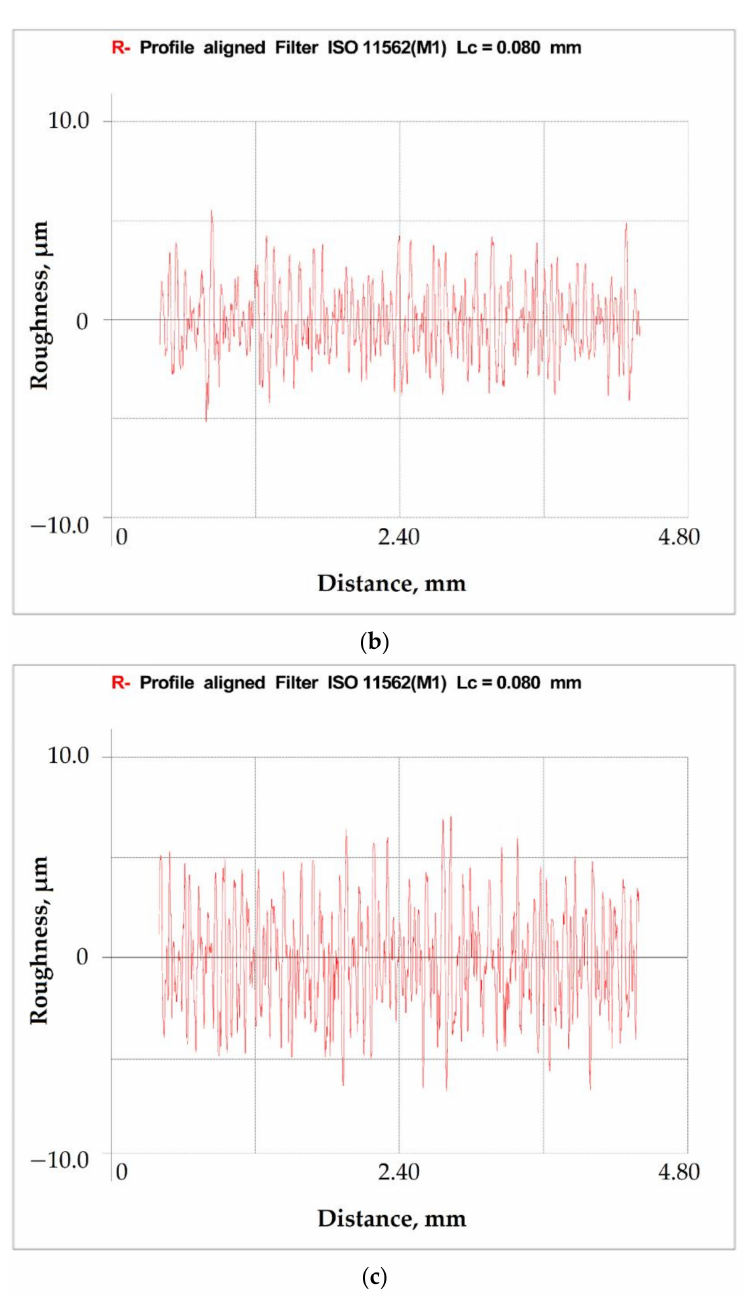
Figure 5. Surface microroughness of the 20Kh13 (DIN 1.4021) steel samples before and after various types of postprocessing: ( a ) after processing; ( b ) after cavitation-abrasive finishing; ( c ) after plastic